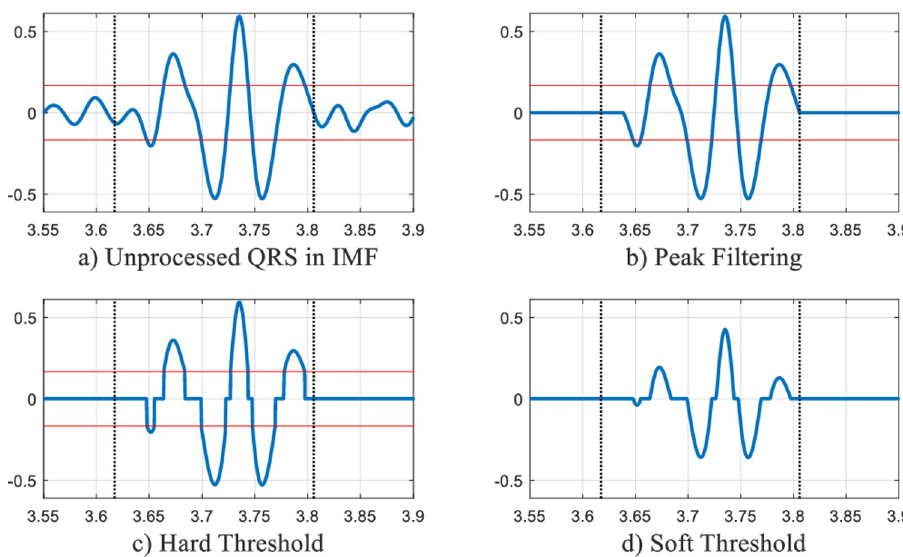
Fig 4. Comparison of QRS detail waveforms denoised by three denoising